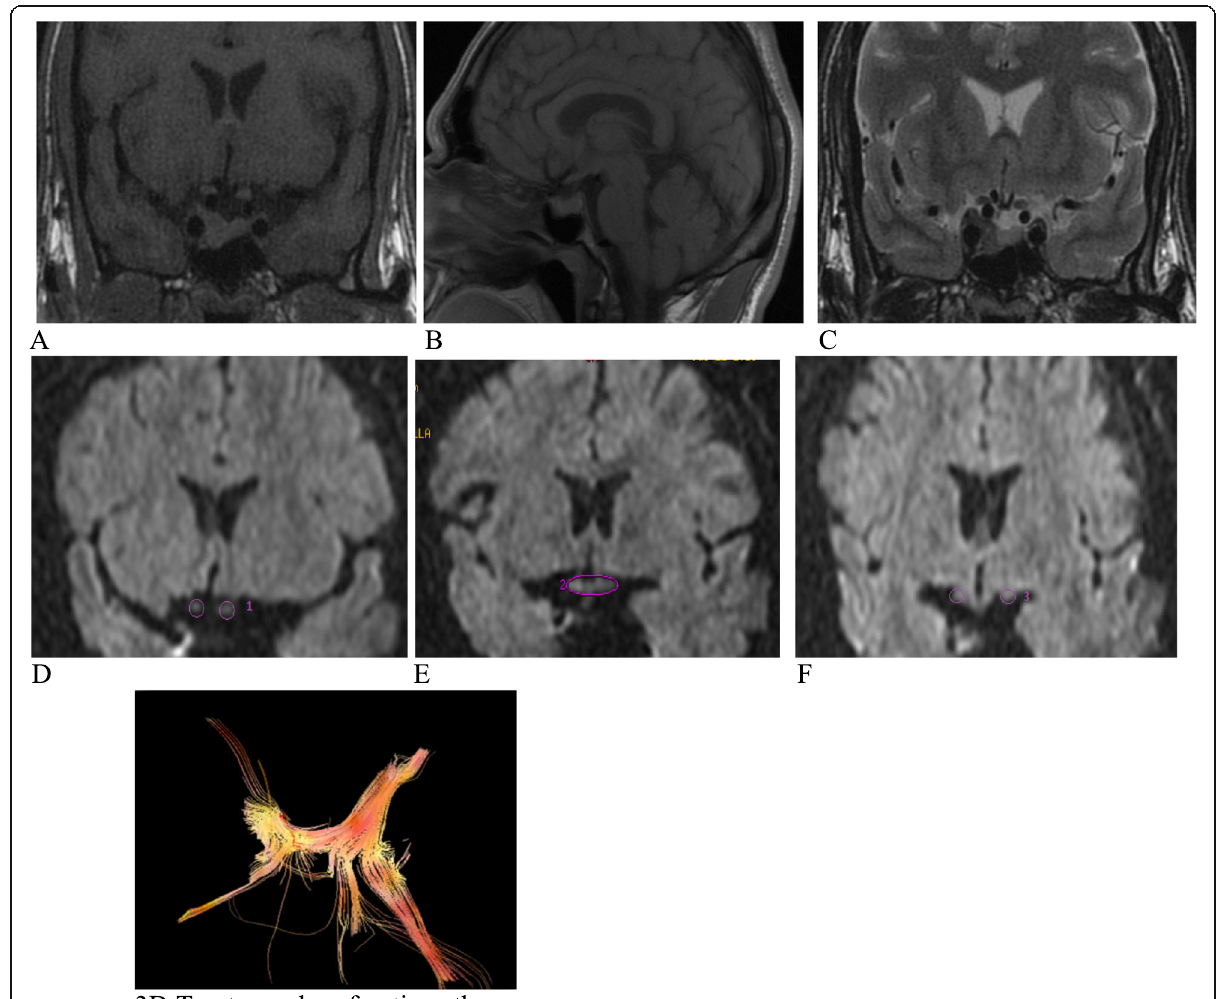
Fig. 1 A case of 37-year-old male patient presented with headache and visual disorder. MRI of the sella coronal T1 ( a ) and sagittal T1 ( b ), coronal T2 ( c ), and DTI of the optic pathway were done and ROI delineation on DTI maps. Color ROI are drawn on anterior optic tracts ( d ), the optic chiasm ( e ), and the posterior optic tracts ( f ) showing enhancing sellar soft tissue mass measuring 1.2 × 1.1 × 1.1 mm at three dimensions with right para sellar extension where it extends within the right cavernous sinus encasing right internal carotid artery and DTI examination shows the following: FA = 0.321, 0, 308, 0.311; ADC = 1.50, 1.52, 1.57 μ m 2 /ms; AD =2.3, 2.44, 2.4 μ m 2 /ms; and RD = 1.1, 1.55, 1.2 μ m 2 /ms of the anterior optic tracts, the optic chiasm, and the posterior optic tracts respectively. The increased value of FA and decreased values of ADC, AD, and RD more at the anterior optic tracts denoting compression more at the anterior optic